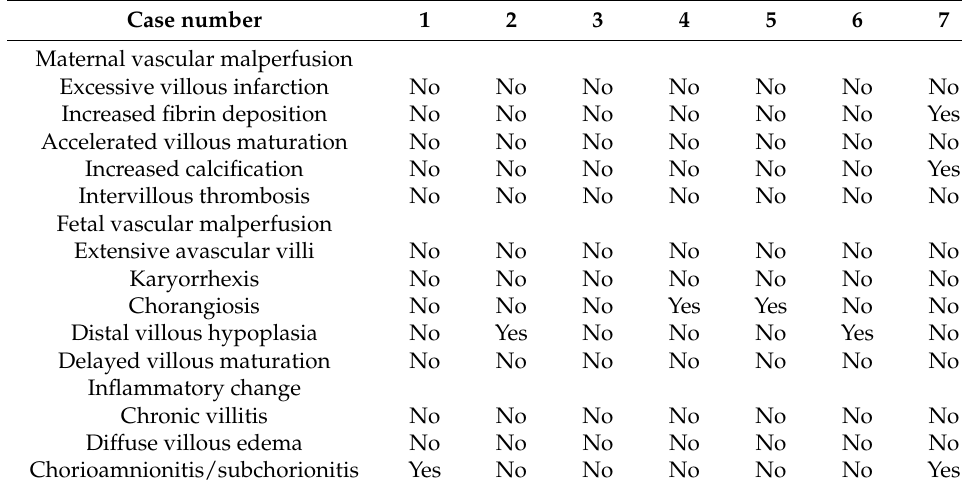
Table 5. Placental pathologic